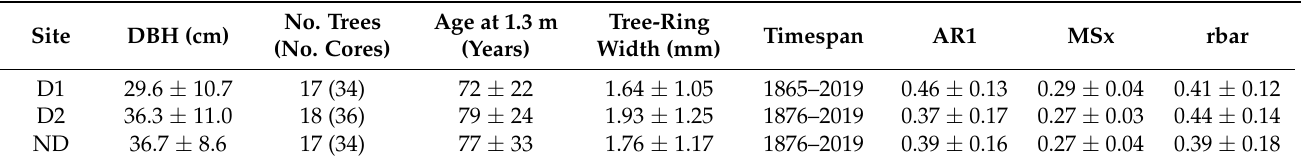
Table 2. Characteristics of sampled trees and tree-ring data. Dendrochronological variables were cal- culated over the common period 1947–2019.Variables’ abbreviations: AR1, first-order autocorrelation; MSx, mean sensitivity; rbar, mean inter-series correlation. Values are means ±